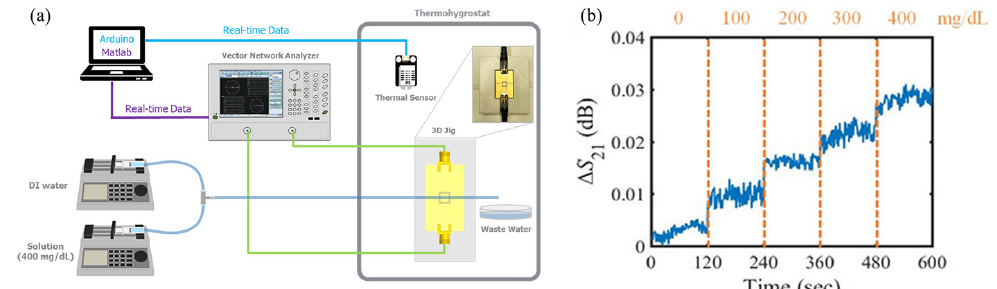
Figure 12. Glucose concentration detection using a complementary split-ring resonator with tem- perature correction. ( a ) Experimental setup for continuous measurement of glucose concentration. ( b ) Variation in the transmission coefficient of the sensor as a function of the glucose concentration after temperature correction [103].